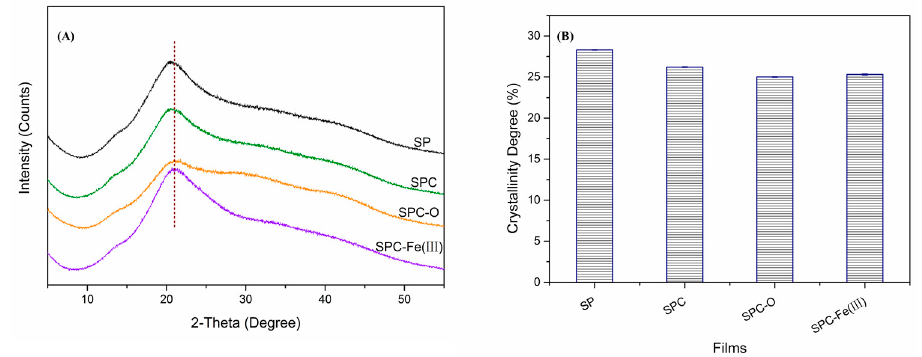
Figure 3. ( A ) X-ray diffraction patterns; ( B ) crystallinity of control and soy-based composite films.